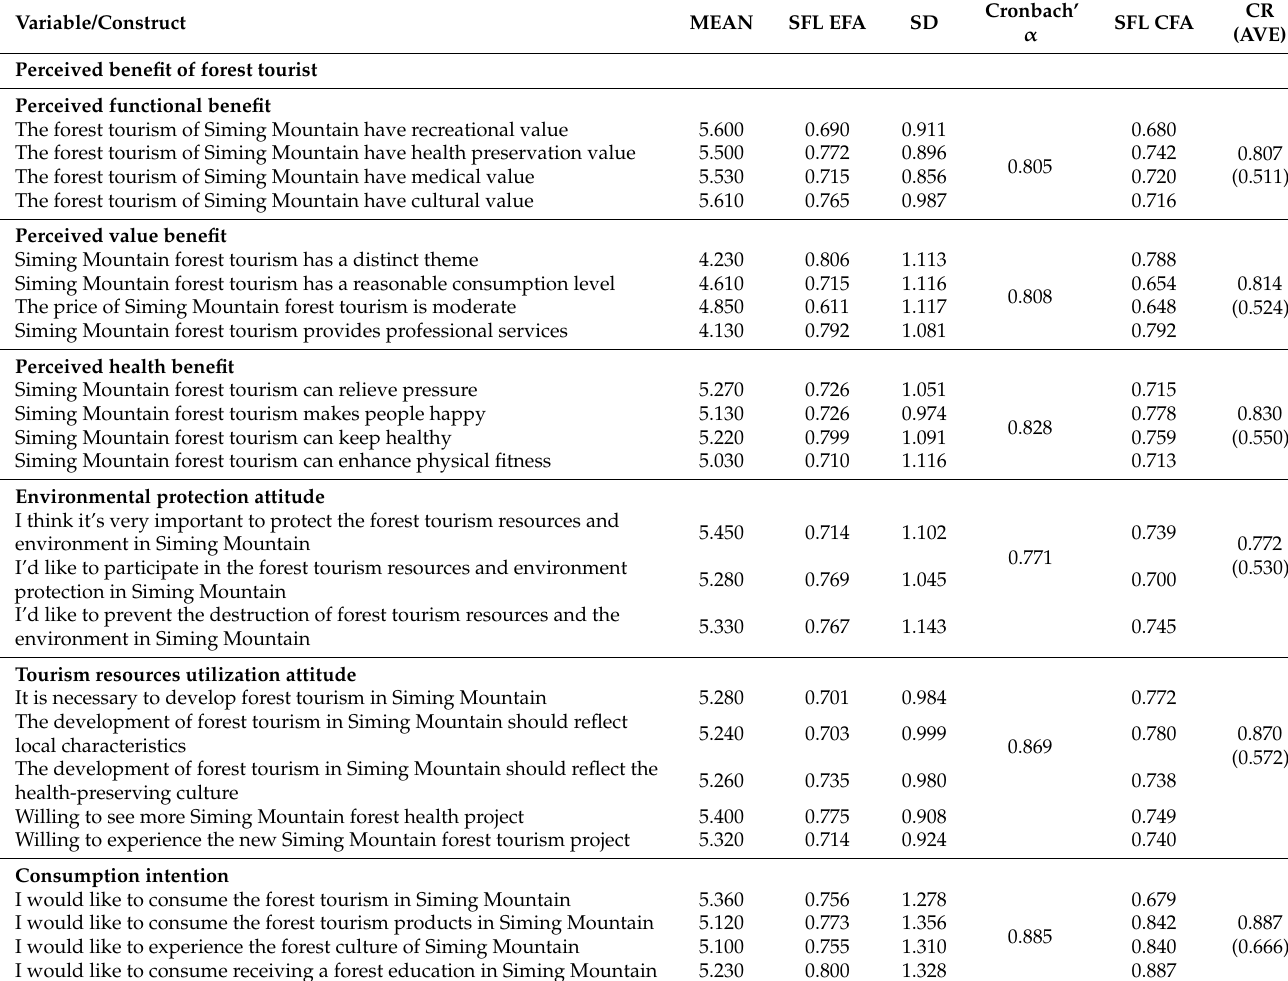
Table 1. Results of exploratory factor and confirmatory factor